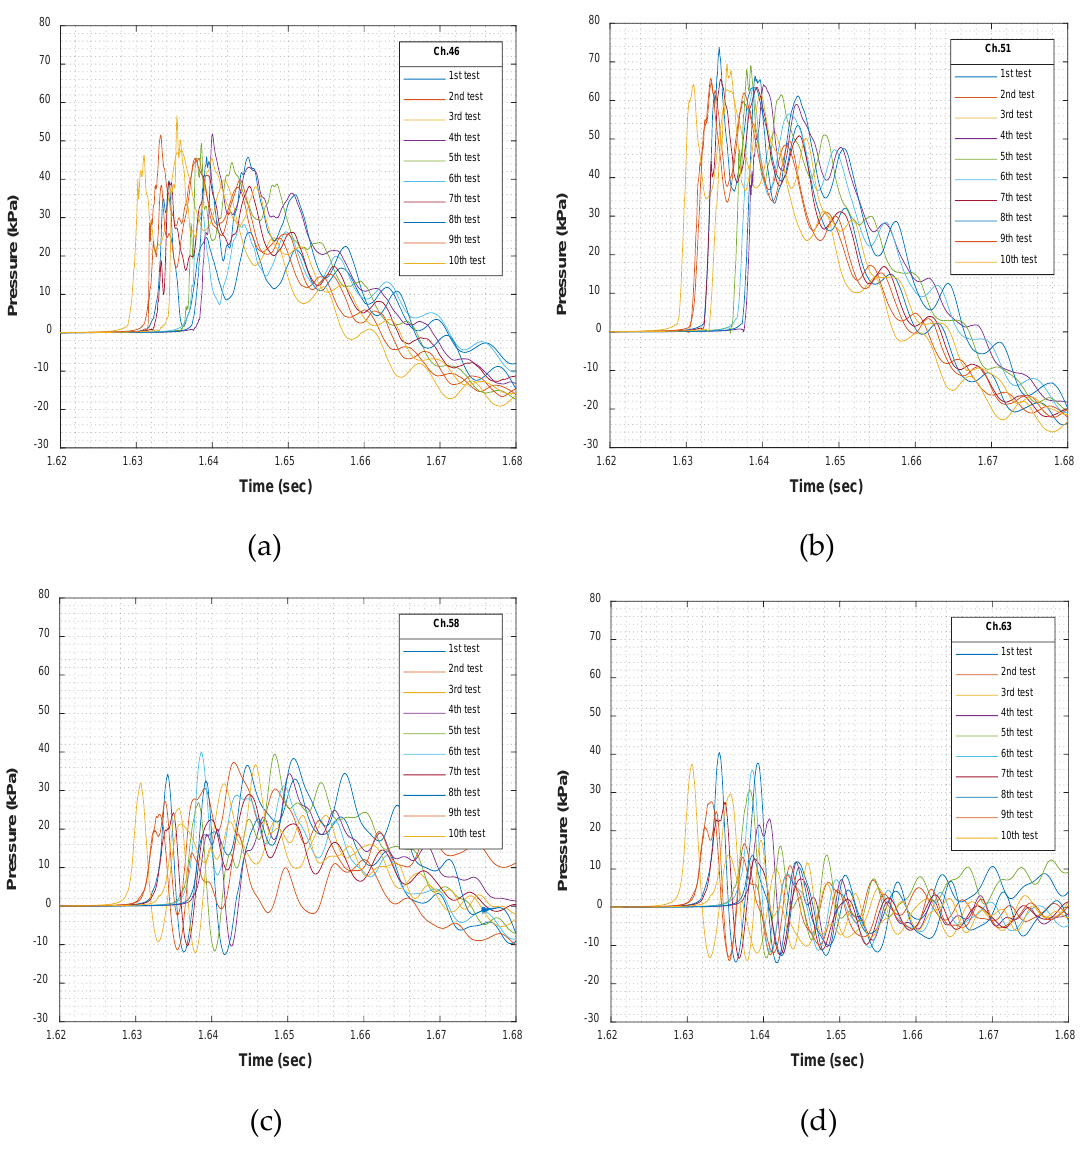
Figure 16. Time Histories of the Pressure Measured at Four Different Channels for SWAY (Wet): ( a ) Channel 46, ( b ) Channel 51, ( c ) Channel 58 and ( d ) Channel 63.